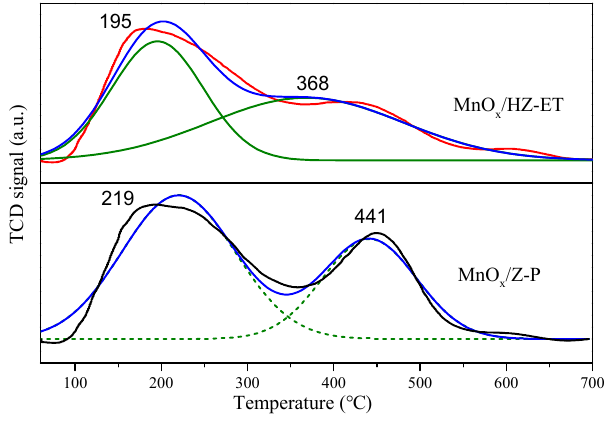
Figure 6. NH 3 -TPD of the catalysts. Table 4. The NH 3 desorption of the catalysts.